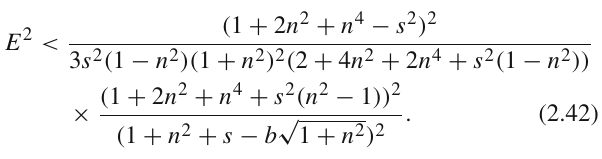
Fig. 1b, the allowed maximal and minimal values for spin s are marked by the red points. Specifically, the allowed max- imal value of spin s max ≈ 0 . 81934 with n ≈ 0 . 60494, and the allowed minimum values of spin s min ≈ − 0 . 67377 with n ≈ 0 .